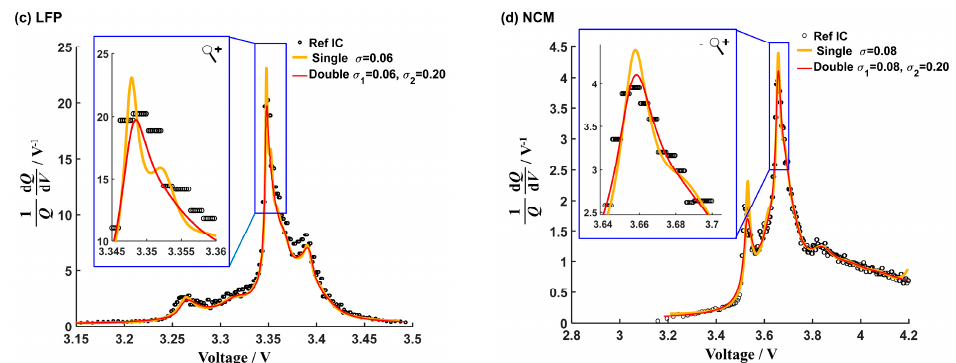
Figure 9. Using double σ to improve the accuracy of the SVR algorithm. ( a ) The curve fitting of the voltage for Cell A with LFP cathode. ( b ) The curve fitting of the voltage for Cell B with NCM cathode. ( c ) The fitting result of the IC curve for Cell A with LFP cathode. ( d ) The fitting result of the IC curve for Cell B with NCM cathode.